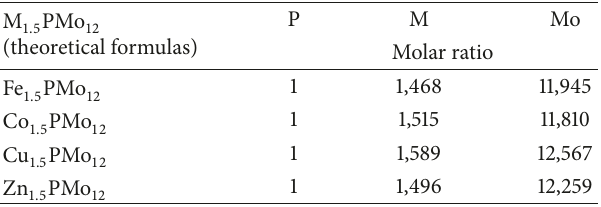
Table 1: Elemental analysis of the as-prepared unsupported het- eropolyanions salt